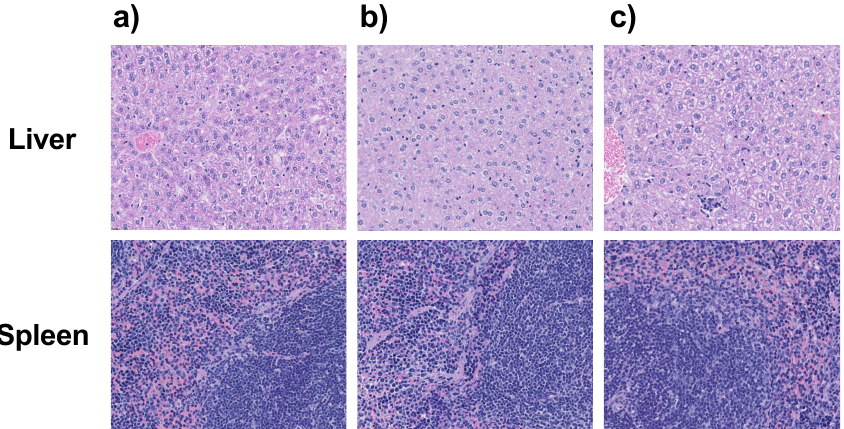
Figure 8. Cross-sections of the liver (upper) and spleen (lower) after staining with haematoxylin and eosin (H & E) 2–3 days after weekly injections for 6 weeks with saline ( a ), dual-targeted PTX+EVER-loaded nanoparticles (Dual-NPs) ( b ), and free paclitaxel and everolimus (PTX+EVER) ( c ) at a PTX-equivalent dose of 15 mg/kg. Magnification, 20X ( n = 5–8).